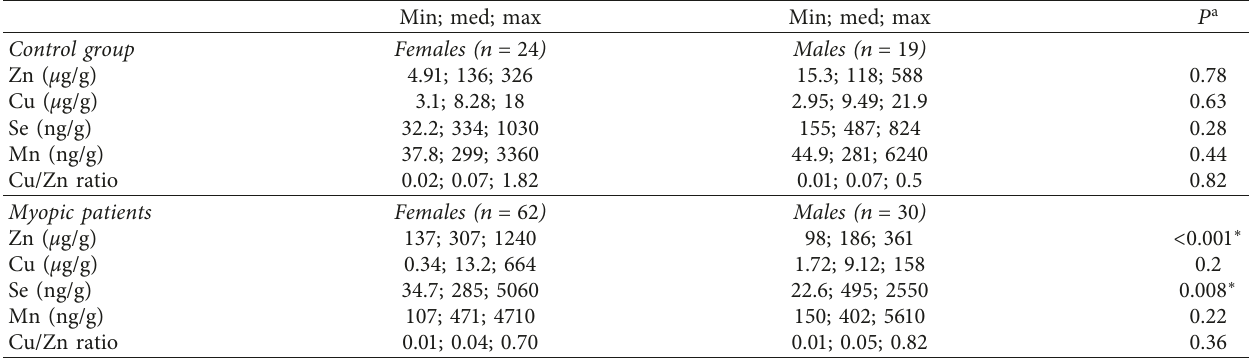
Table 5: The influence of sex for serum trace elements concentration and Cu/Zn ratio in control and myopic patients groups.